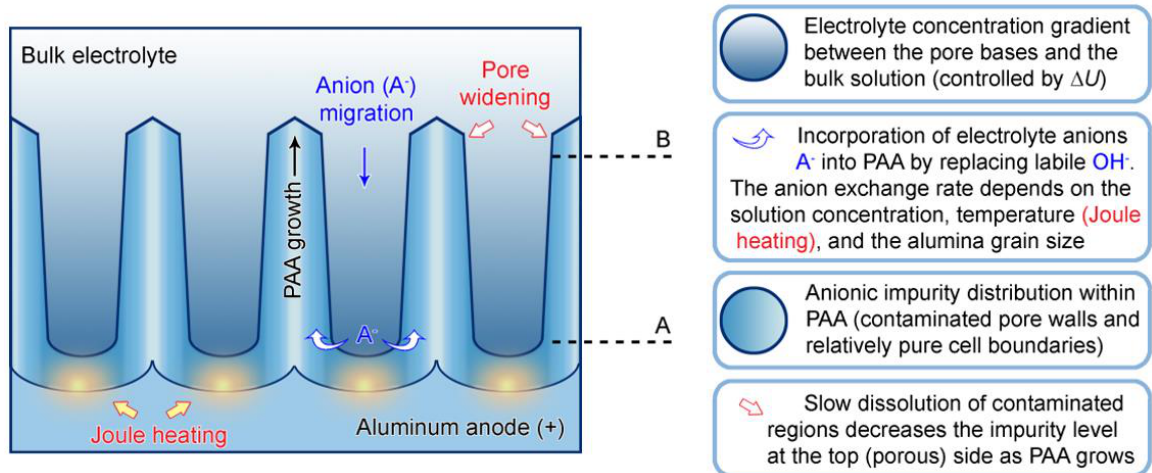
Figure 16. Schematic representation of non-uniform electrolyte impurity distribution within PAA controlled by two key processes: ion exchange (i.e., replacement of labile OH − counterions by electrolyte anions from the solution) and slow chemical dissolution of the anion-contaminated regions of pore walls. Since the rate of ion exchange and diffusion within PAA depends on the electrolyte concentration, temperature, and the grain size, the main fraction of electrolyte anions is incorporated into pore walls at the pore bases (position A). As the pore walls grow higher, a slow densification of PAA to a stable mineral form occurs, and the anion exchange rate decreases (position B). The slow dissolution of contaminated pore interiors results in a gradually increased ratio of pure alumina to contaminated alumina. Therefore, there is a contamination level gradient along the pore growth direction.